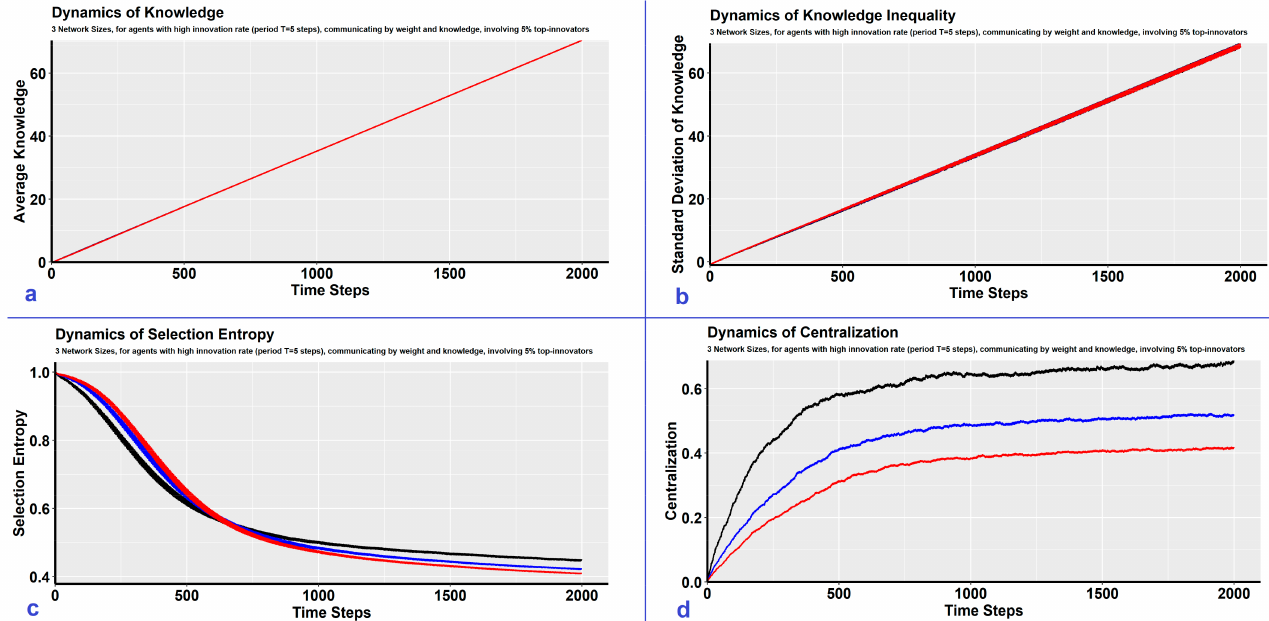
Figure 5. Simulations for the 3 different network sizes: N = 100 agents (black), N = 200 agents (blue), N = 300 agents (red). Results are illustrated for: ( a ) the average knowledge (Definition 8, up left), ( b ) the standard deviation of knowledge (Definition 9, up right), ( c ) the selection entropy (Definition 10, down left), ( d ) the centralization (Definition 13, down right). The y axis for the average knowledge ( a , up left) and the standard deviation of knowledge ( b , up right) is in log‑10 scale, indicating the exponential increase of knowledge dynamics. Results are illustrated for agents with high innovation rate (period 𝑇 = 5 steps), communicating by weight and knowledge ( s = 𝓌𝓀 ), involving 5%